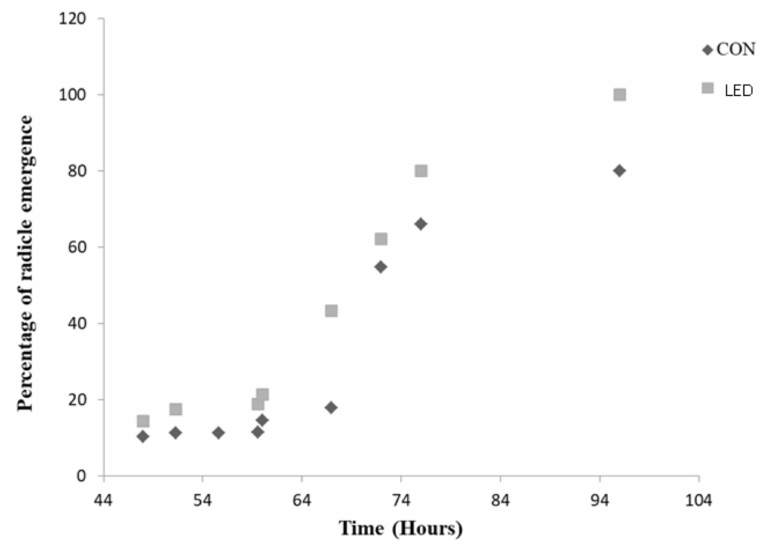
Figure 2. Percentage of radicle emergence (from 48 h to 96 h) in Control (CON, unlighted) and irradiated R LED (LED) pepper seeds after Phases I and II of